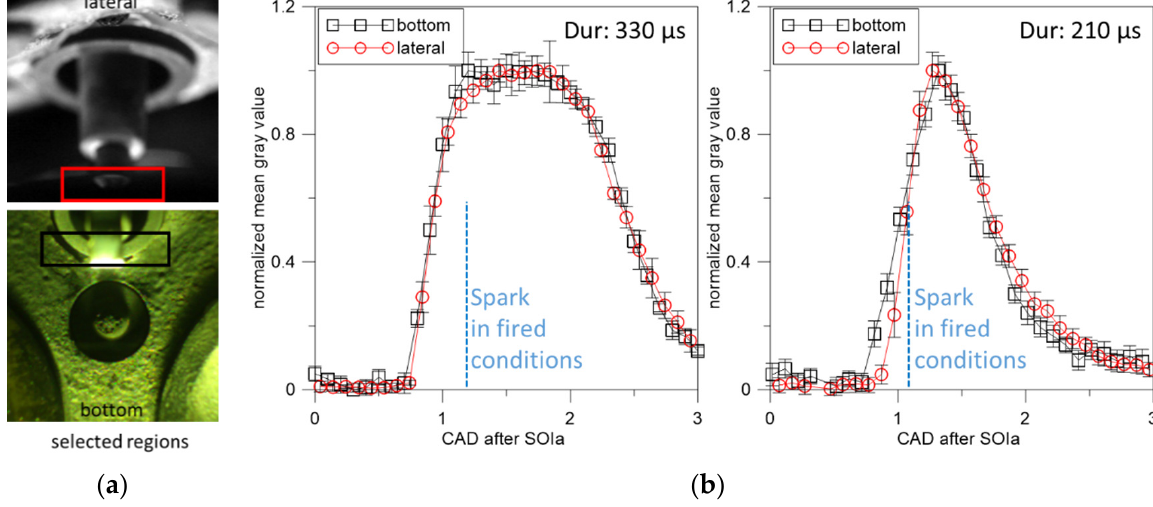
Figure 16. Regions of the combustion chamber ( a ) corresponding to the spark gap used to calculate the mean gray value of Mie-scattered light intensity ( b ), averaged over all sequences.